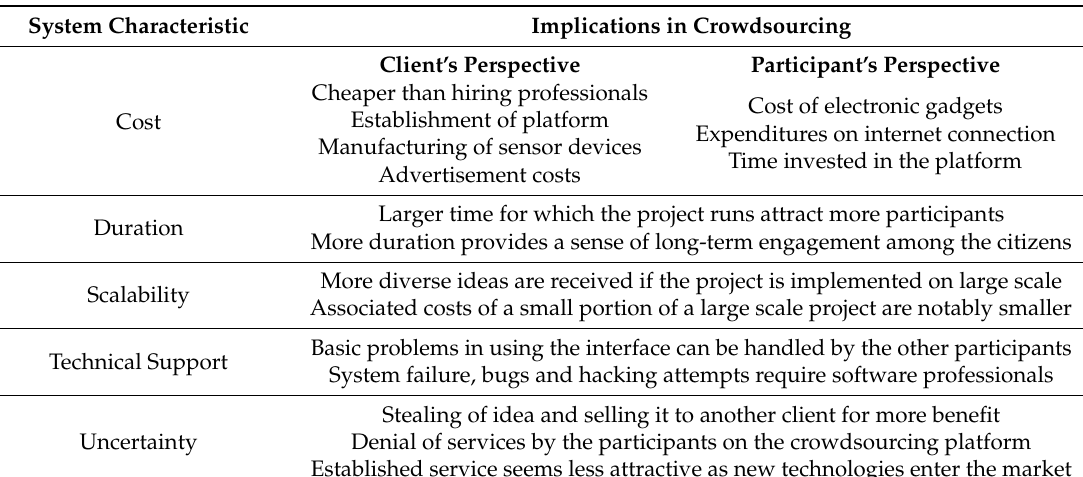
Table 4. System characteristics affecting the feasibility of